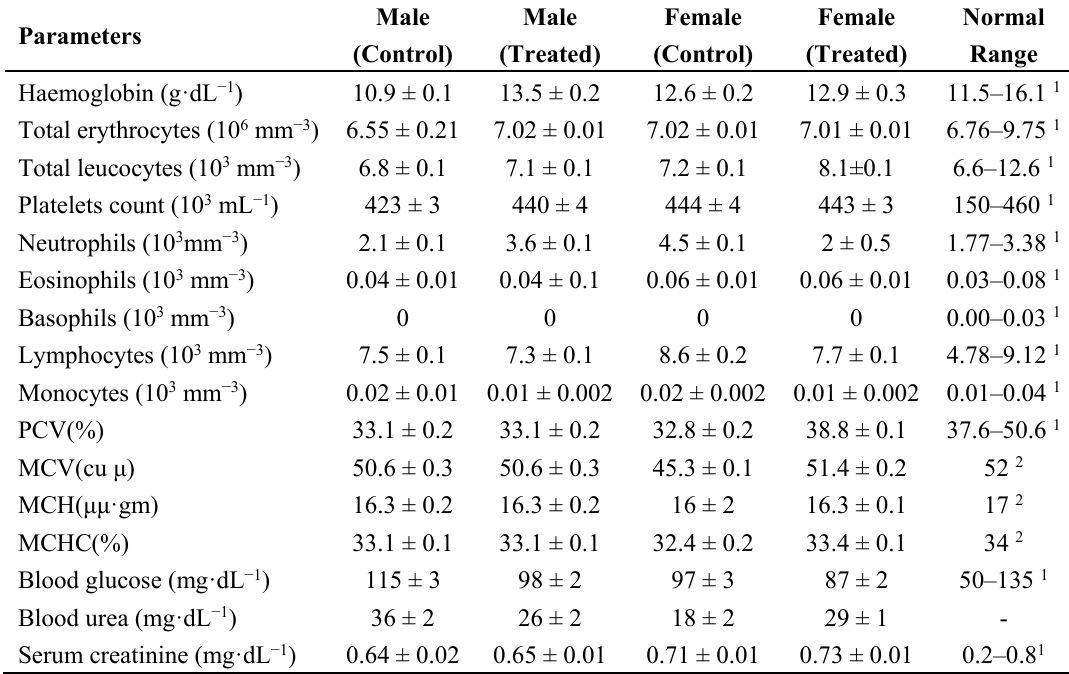
Table 5. Effect of oral administration of tomato powder suspension on haematological parameters of Wistar rats fed for 28 consecutive